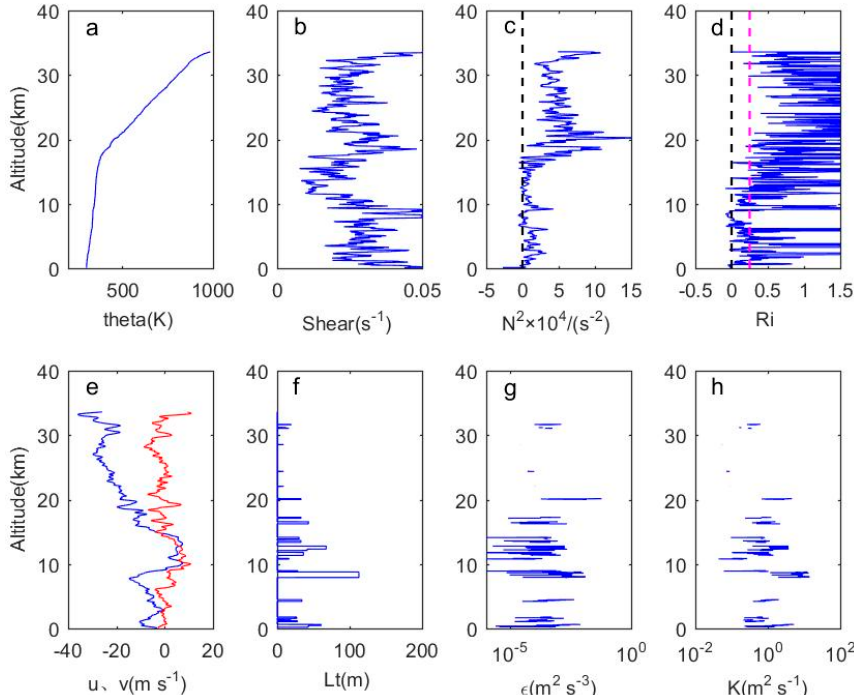
Figure 3. At 0012 UT on 31 May 2018, ( a ) temperature, ( b ) vertical shear of wind speed, ( c ) buoyancy frequency, ( d ) gradient Richardson number, ( e ) wind speed component (latitude component: blue solid curve; meridional component: red solid curve), ( f ) Thorpe length, ( g ) energy dissipation rate, ( h ) turbulent diffusivity profile.